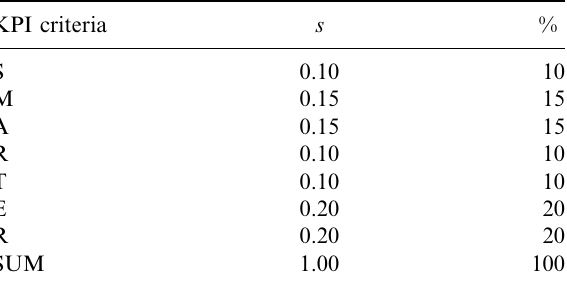
Table 6. Weights given to a particular criterion for KPI selection KPI criteria